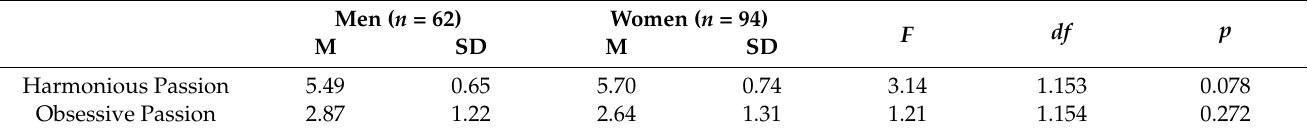
Table 9. Summary of the ANOVA of one factor: DMP considering gender.